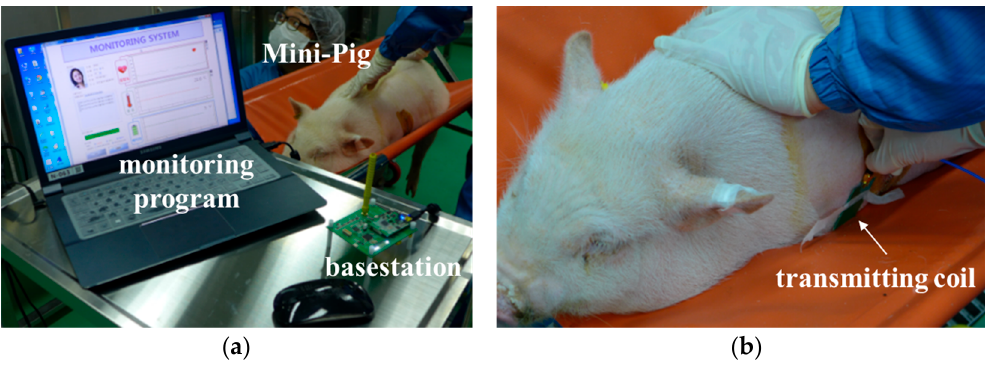
Figure 4. Animal experiment: ( a ) Experiment setup and ( b ) wireless charging.